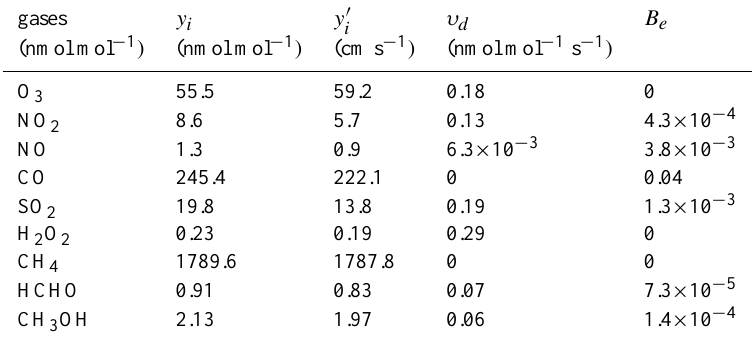
) mixing ratios, deposition velocities ( υ d ) and emission rates ( B e ) of key gases. Table 2. The initial ( y i ) and upwind ( y 0 i gases